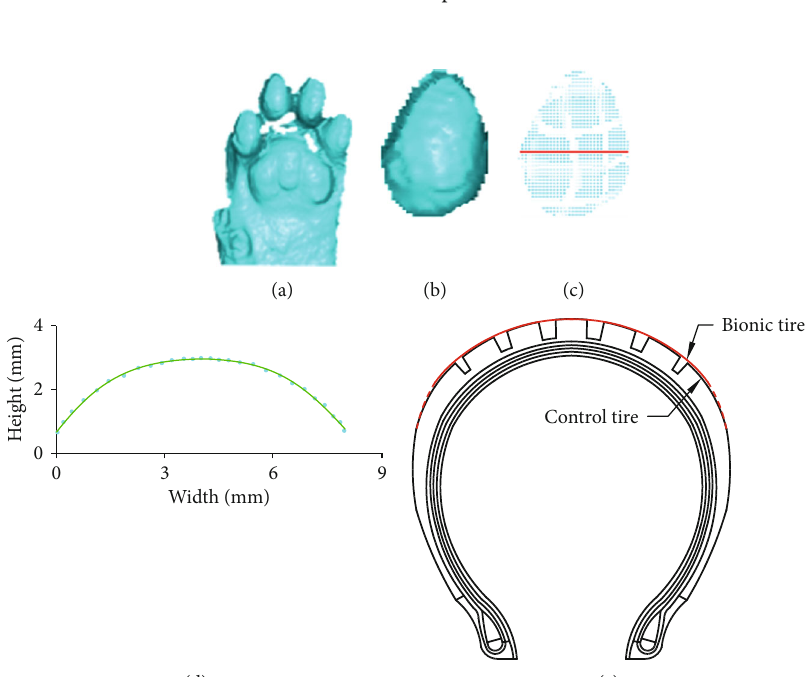
Figure 6: (a) Geometry of forepaw pad surface; (b) geometry of third forepaw pad; (c) point cloud of third forepaw pad surface; (d) lateral curve fi tting of extracted points; (e) type 2.75-18 motorcycle tire.